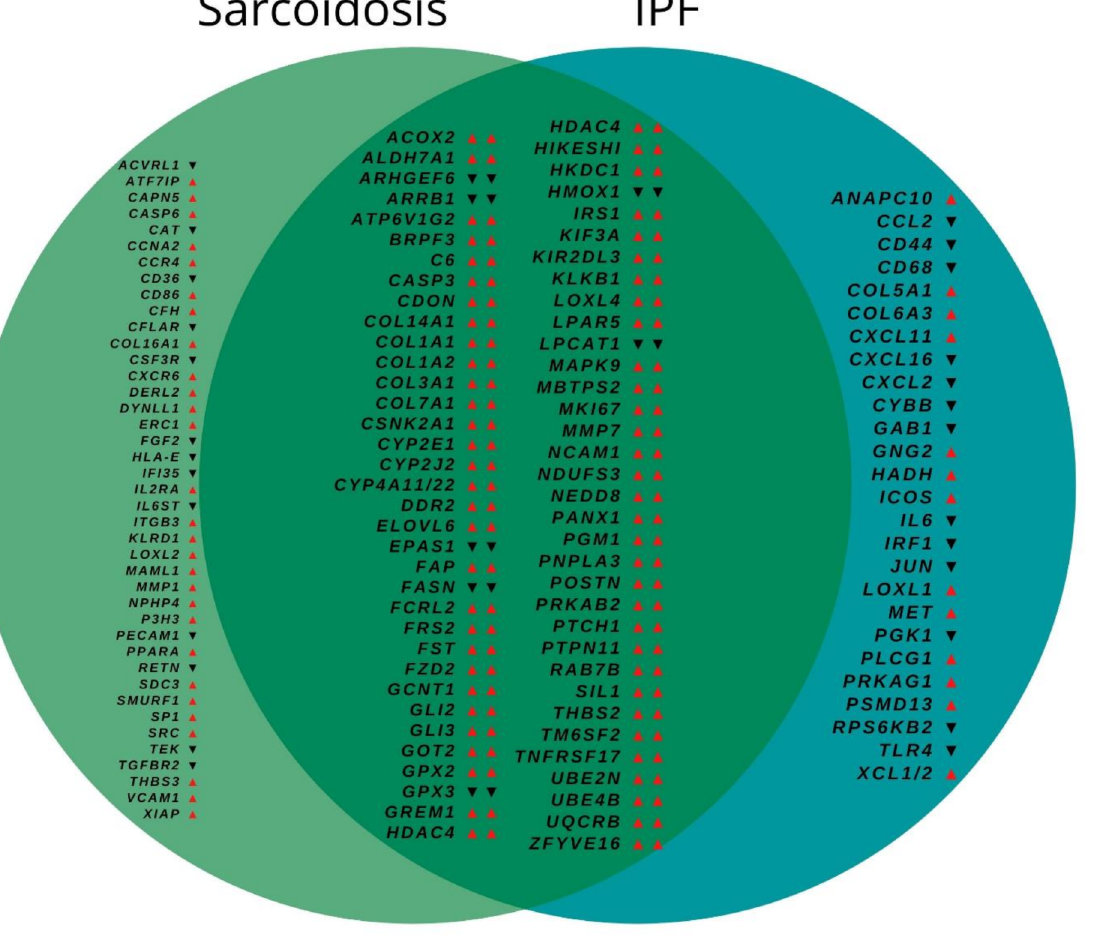
Figure 2. Venn diagram of differentially regulated genes. Arrows indicate significantly increased (arrow up) or significantly decreased (arrow down) expression of the respective genes compared to controls in fibroblastic foci from both disease entities compared to healthy control lungs. Holm Bonferroni corrected p -values < 0.05 were considered as statistically significant. In the overlapping area (middle), left and right arrow indicate the expression in sarcoidosis and IPF, respectively. IPF, idiopathic pulmonary